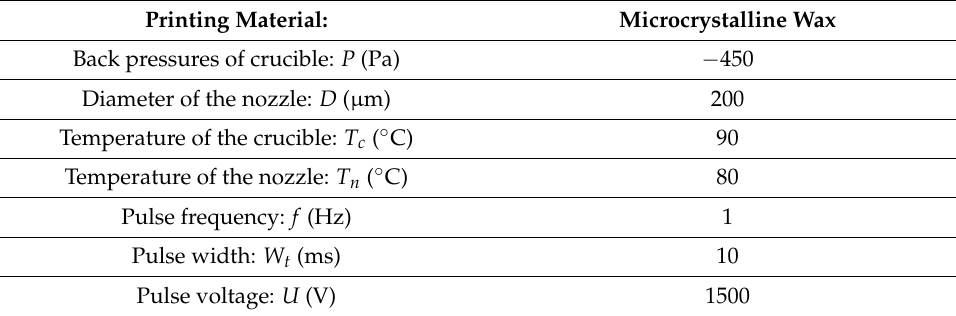
Table 1. Process parameters of Taylor cone and droplet ejecting. Printing